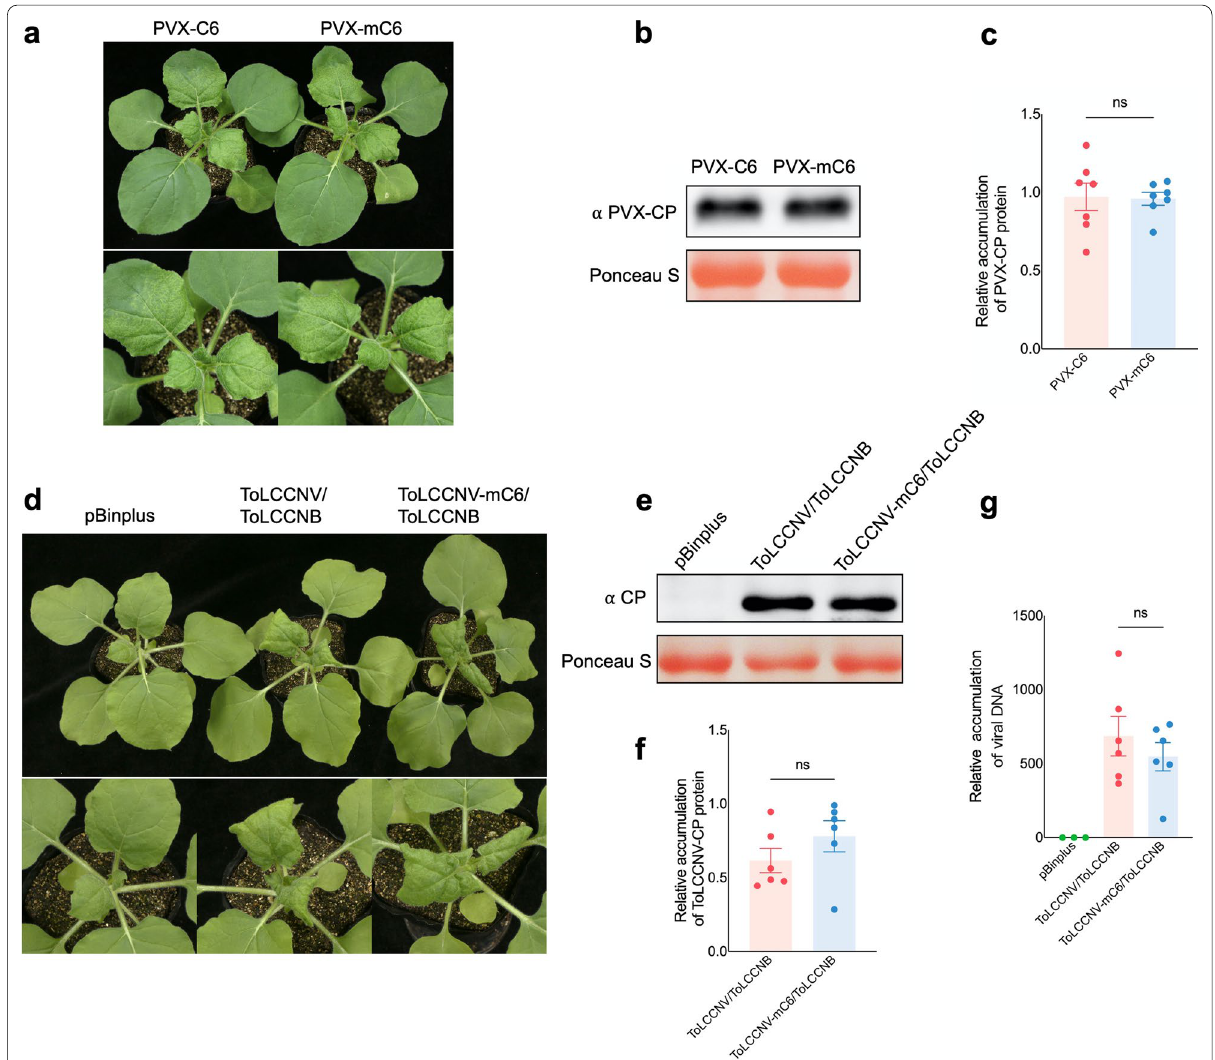
Fig. 5 ToLCCNV C6 protein is dispensable for virulence. a Symptoms in Nicotiana benthamiana plants at 8 days post‑inoculation (dpi) with PVX‑C6 or PVX‑mC6. b Western blot analysis of PVX coat protein (PVX‑CP) accumulation in plants infected with PVX‑C6 or PVX‑mC6. Ponceau S staining of Rubisco shows protein loading. c Quantification of PVX‑CP accumulation in plants infected with PVX‑C6 or PVX‑mC6, analyzed from the Western blot images using Image J. Data are the mean of seven independent biological replicates. d Symptoms of N. benthamiana plants infected with ToLCCNV/ToLCCNB, ToLCCNV‑mC6/ToLCCNB, or control (pBinplus) at 8 dpi. e Western blot analysis of ToLCCNV coat protein (CP) accumulation in systemic leaves shown in d . Ponceau S staining of Rubisco shows protein loading. f Quantification of CP accumulation in N. benthamiana plants infected with ToLCCNV/ToLCCNB or ToLCCNV‑mC6/ToLCCNB, analyzed from the Western blot images using Image J. Data are the mean of six independent biological replicates. g Viral DNA accumulation in ToLCCNV/ToLCCNB, ToLCCNV‑mC6/ToLCCNB infected or control (pBinplus) plants in d , measured by qPCR. Data are the mean of six independent biological replicates. Error bars represent standard deviation (SD). ns, no significant difference (Student ′ s t ‑test; P 0.05). NbActin was used as an internal ≥